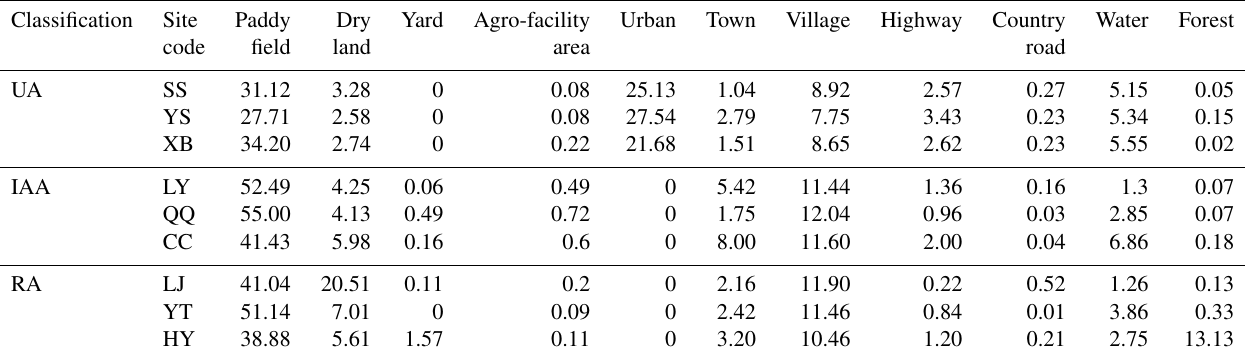
Table 1. The types of land use and areas were divided as follows: agricultural area (paddy field, dry land, yard and agro-facility area), built-up area (urban, town and village), road (highway and country road), water and forest. Classification